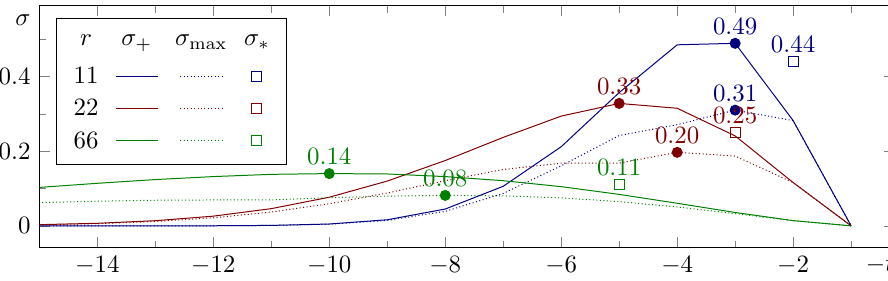
Figure 1: Probability σ of successful sampling for r ∈ { 11 , 22 , 66 } dummy